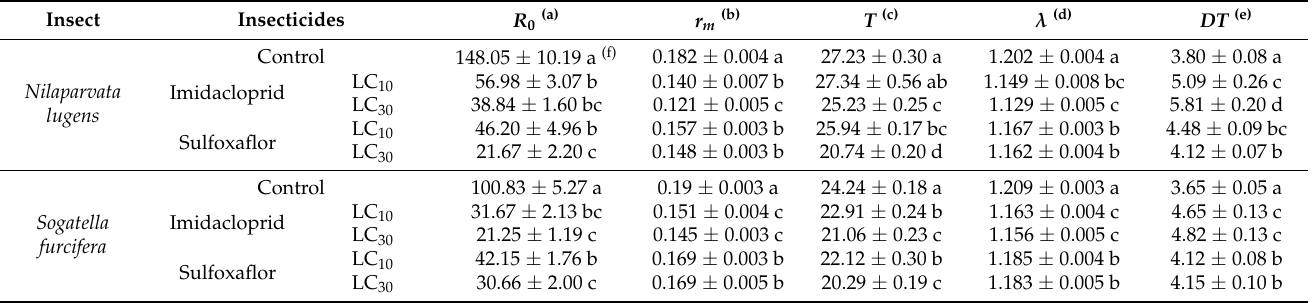
Table 5. The mean rates of stable population parameters of Nilaparvata lugens and Sogatella furcifera